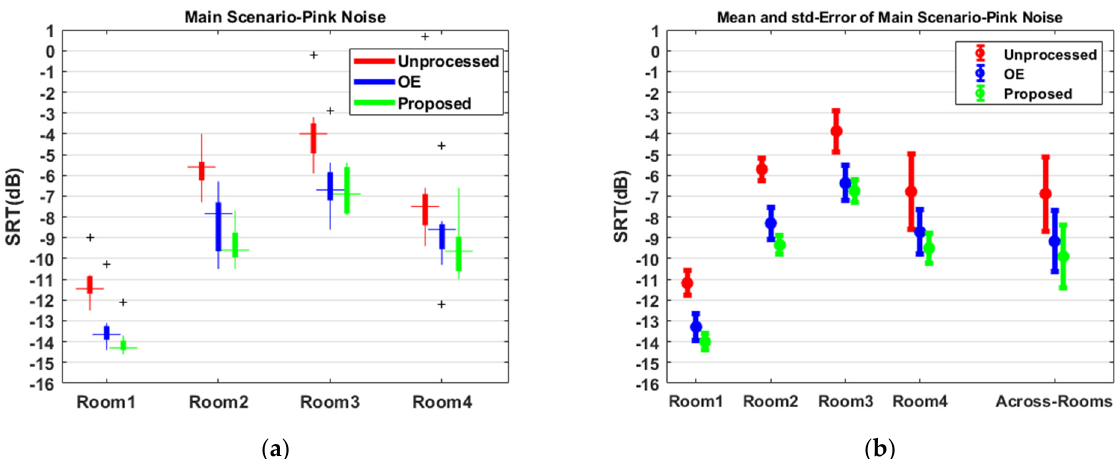
Figure 9. ( a ) Boxplots of speech reception thresholds at SRT 50 for 8 subjects in the presence of pink noise (PN) are illustrated. The unprocessed and the preprocessed signals for the main scenarios using the OE and proposed method are compared; ( b ) The mean-SRT 50 and the standard errors for the same data are plotted.